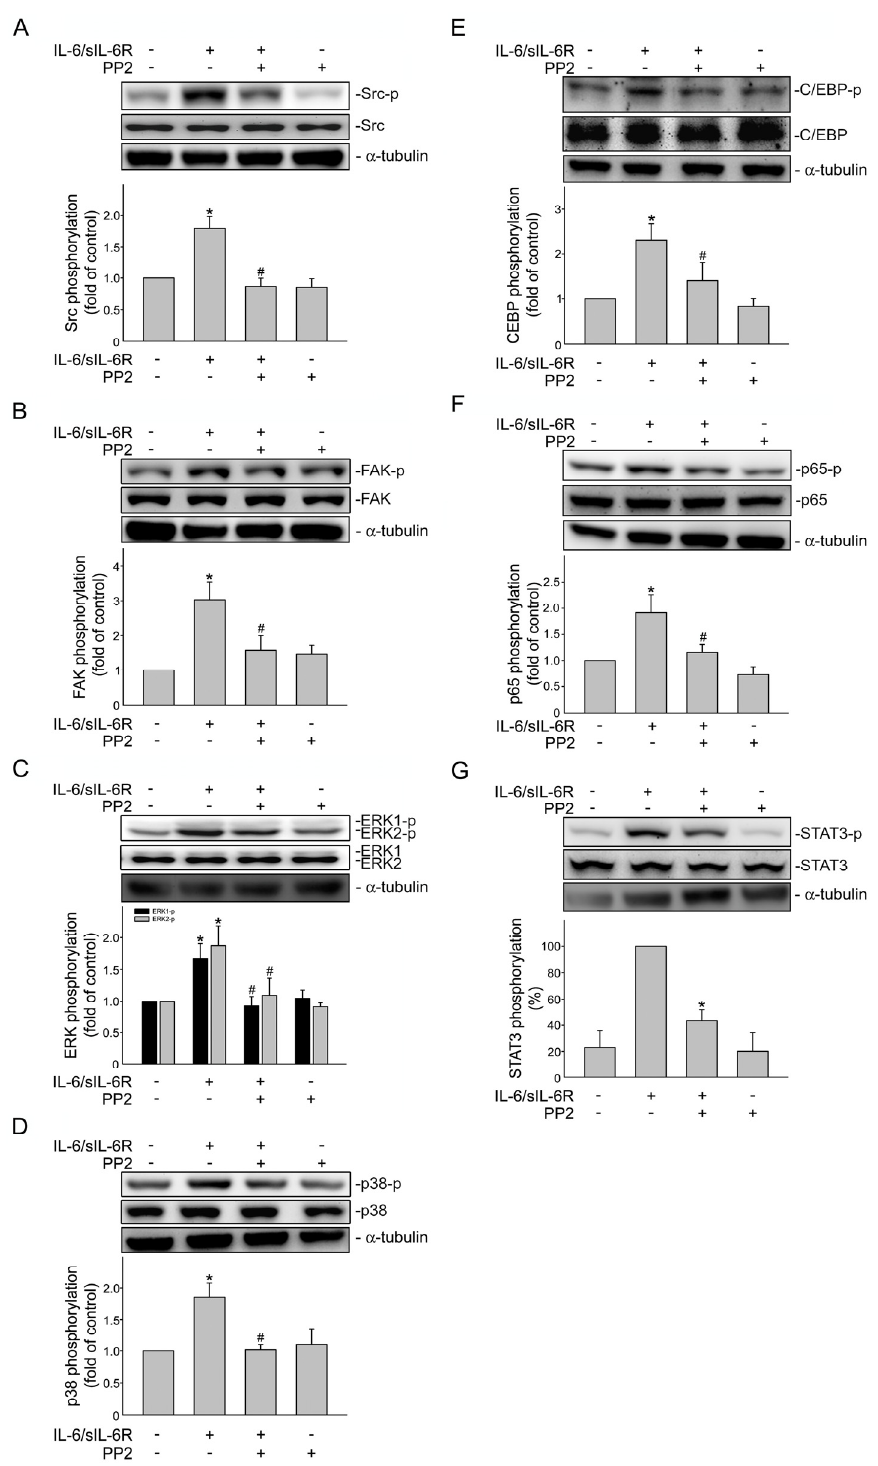
Figure 4. Src mediates IL-6-induced FAK, ERK1/2, p38MAPK, p65, C/EBP and STAT3 phosphorylation in HCT116 cells. Cells were treated with PP2 (1 μ M) for 30 min and stimulated by IL-6/sIL6R (20 ng/mL) for another 30 min. Immunoblotting was used to examine Src ( A ), FAK ( B ), ERK1/2 ( C ), p38MAPK ( D ), p65 ( E ), C/EBP ( F ) and STAT3 ( G ) phosphorylation status. Bar graph represents the mean ± S.E.M. of four independent experiments. * p < 0.05, compared with the control group. # p < 0.05, compared with the group treated with IL-6/sIL-6R